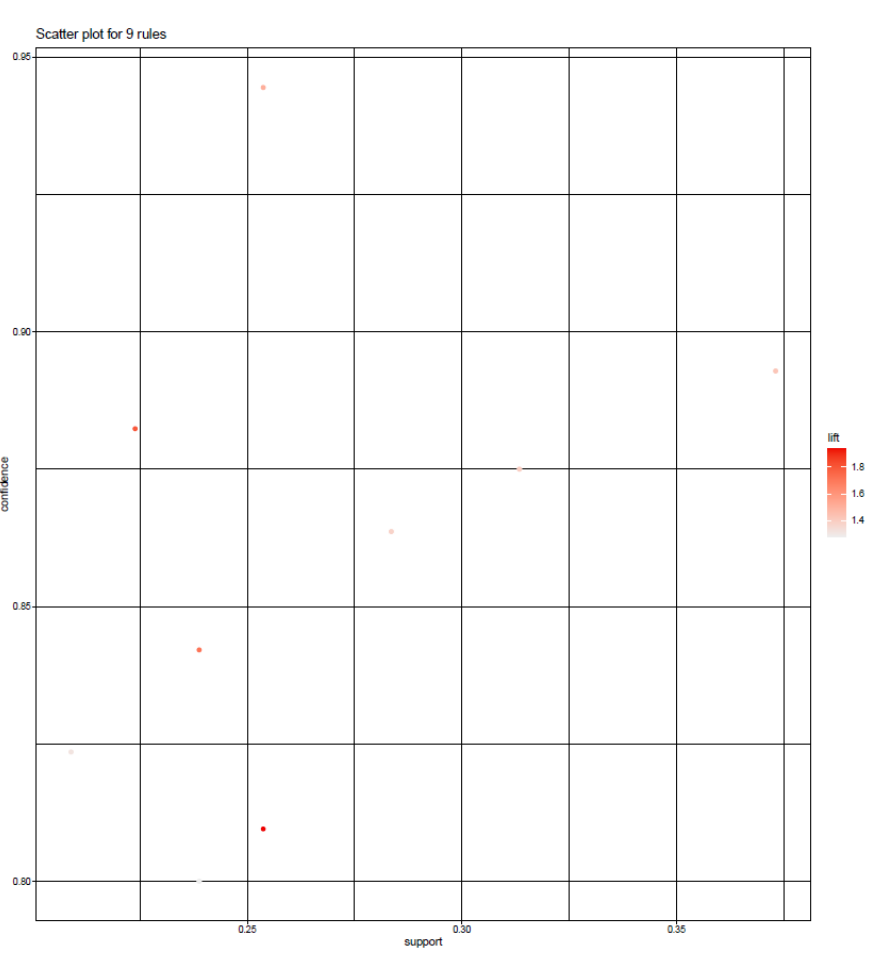
Figure 14. Scatter plot of the association rules in the meta-analysis of EAHM prescribed for peripheral neuropathy.